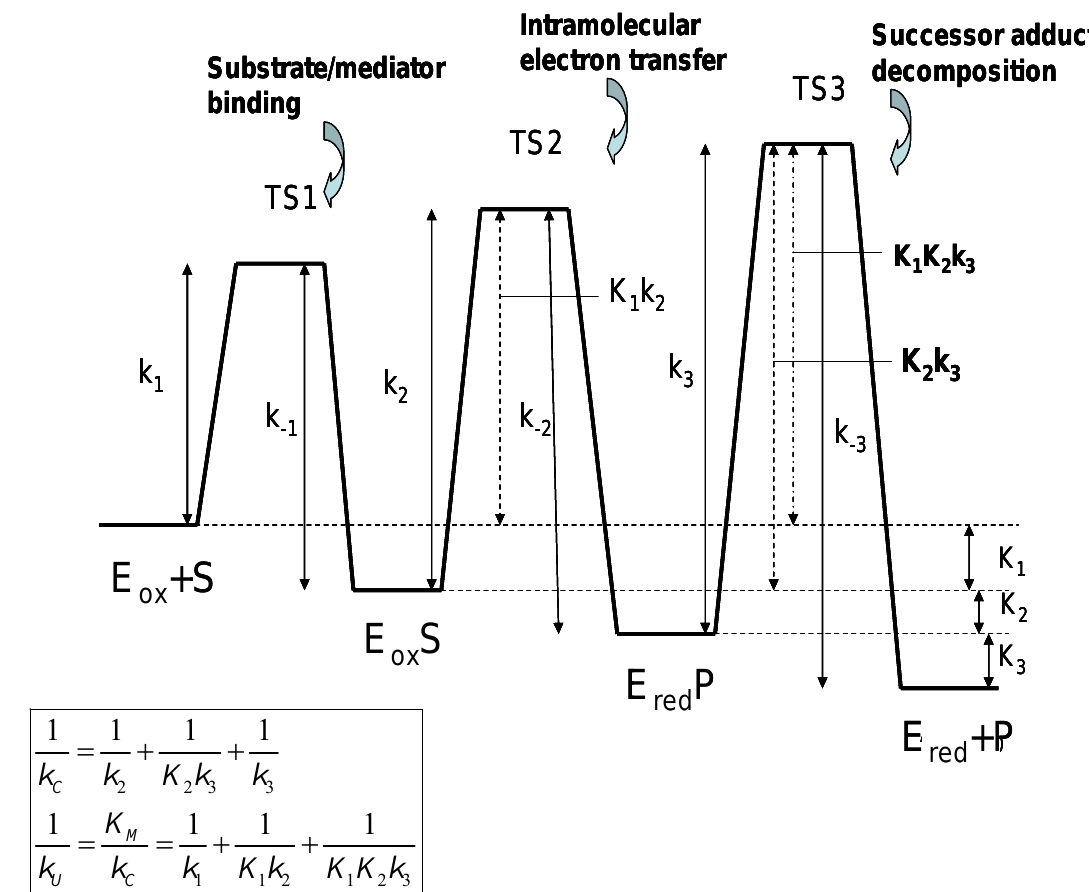
Figure 2. Free Energy profiles for the Michaelis-Menten adduct formation mechanism in which a to form a precursor adduct substrate S binds to a catalytically active oxidized form of the enzyme E ox species E S. This binding process is followed by intramolecular electron transfer in which the ox P is formed, which subsequently decomposes to yield the product P and successor adduct species E red non catalytically active reduced form of the enzyme E red